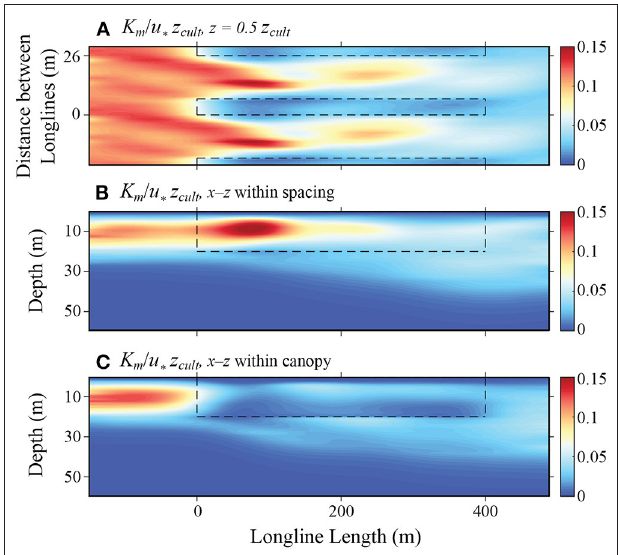
FIGURE 5 | Mean statistics of vertical diffusivity from LES solution with a maximum canopy and deep mixed layer depth: (A) Vertical diffusivity K m , normalized by the product of the surface friction velocity u ∗ and the canopy height z cult , at depth z = 0.5 z cult ; (B) Vertical diffusivity on the x − z plane in the spacing between adjacent canopy rows; (C) Vertical diffusivity on the x − z plane within canopy rows. The black dashed rectangles outline the regions occupied by the